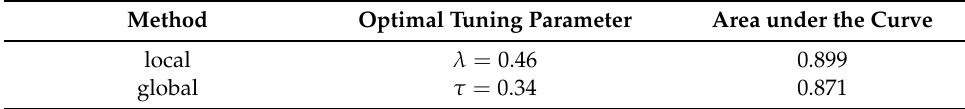
Table 1. Optimal tuning parameters and AUC for both the methods.